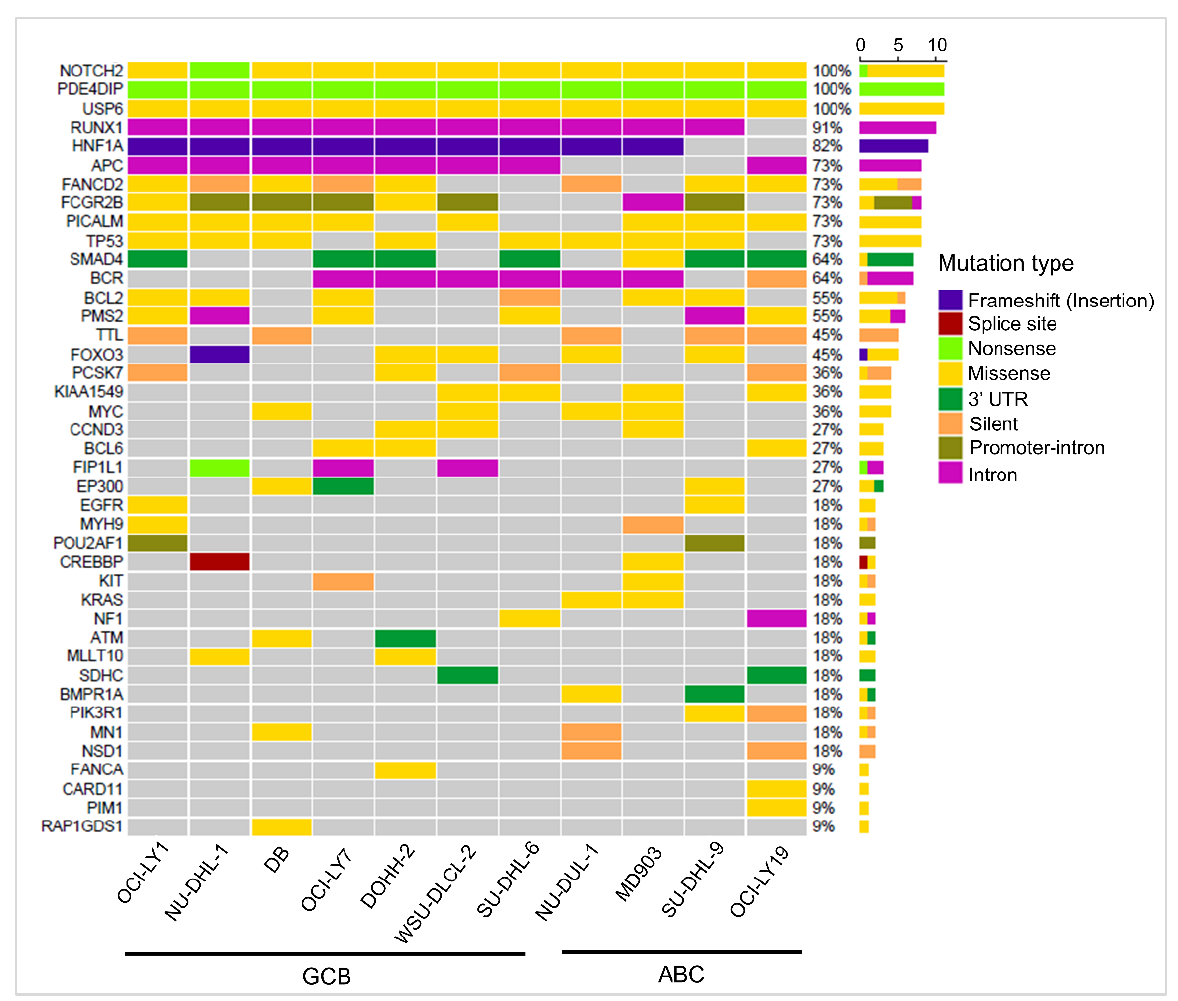
Figure 3. Waterfall plot depicting the mutational landscape of 41 oncogenes and tumor suppressor genes (rows) with SSVs in 11 DLBCL cell lines (columns).